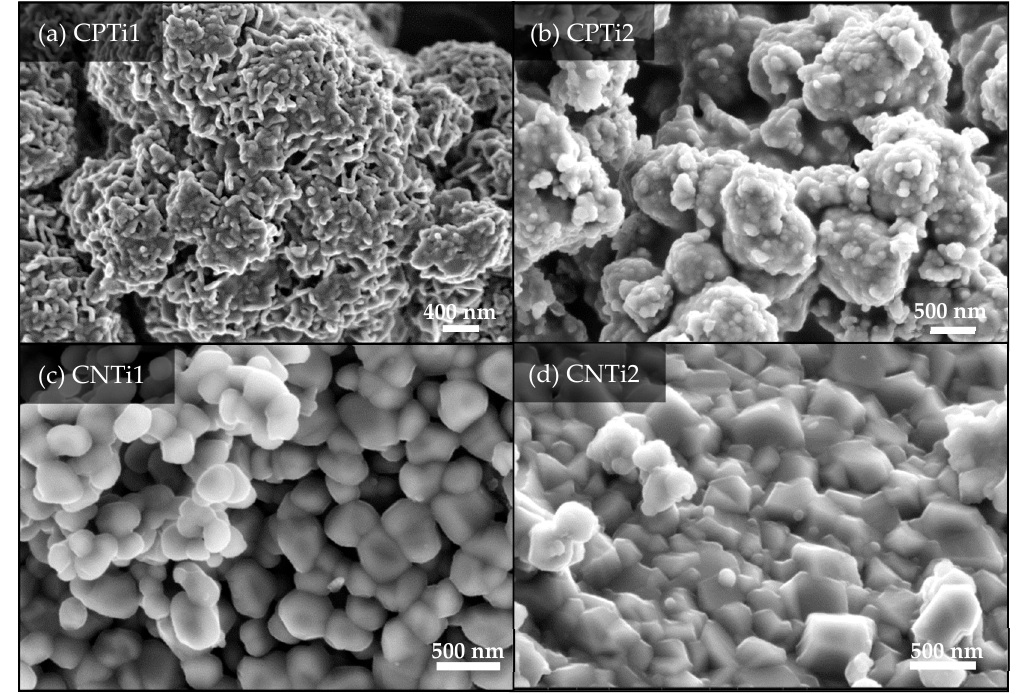
Figure 4. Scanning electron microscopy (SEM) images of the carbon–Ti composites prepared by cellulose treatment with phosphoric acid ( a,b ), or nitric acid ( c,d ).